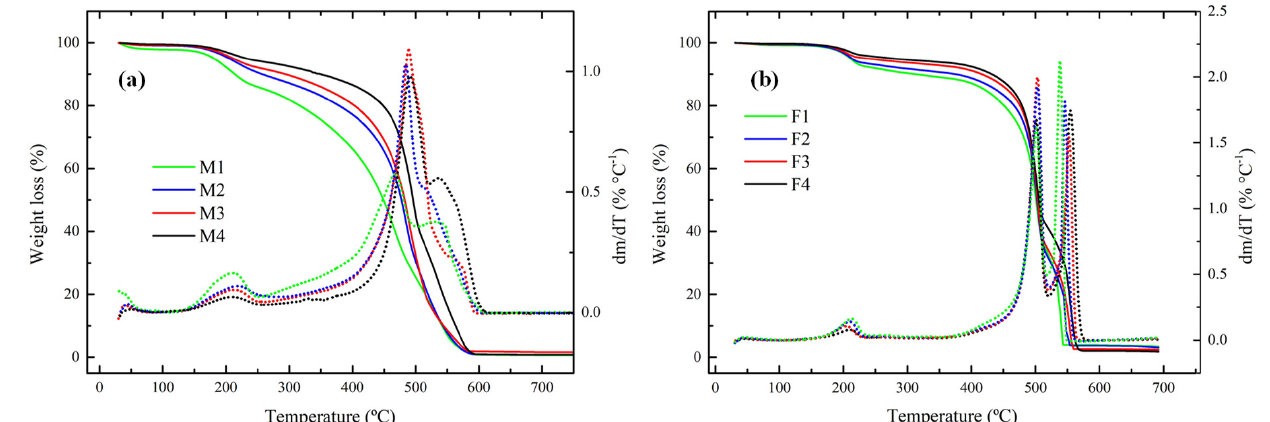
Figure 10. Thermograms for membranes containing: ( a ) PEI and ( b ) Fumion ® in N 2 atmosphere and heating rate of 20 °C min − 1 .